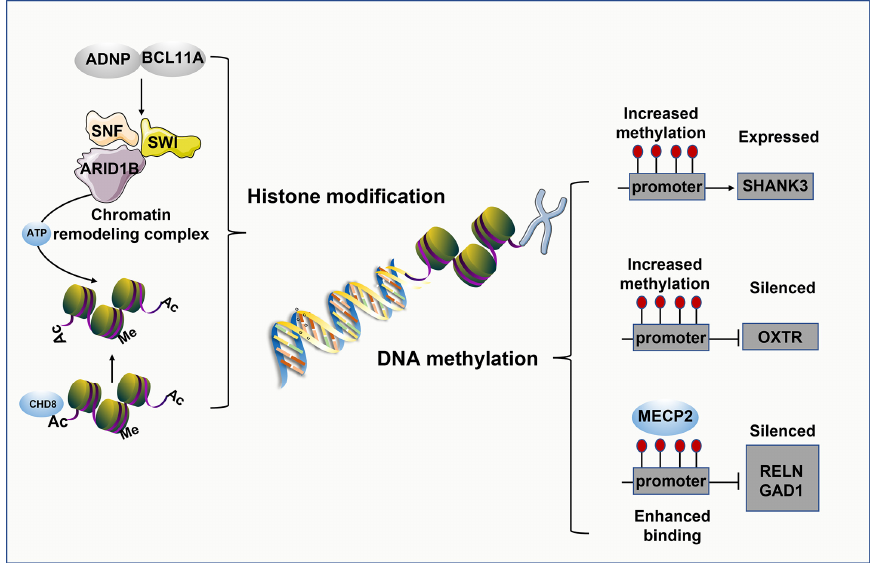
Figure 3. Methylation and acetylation modifications associated with ASD. DNA methylation fre- quently results in transcriptional repression or even gene silence in impacted genes. MECP2 binds to methylated CpG sites in gene promoters and binds to chromatin silencing complexes, inhibiting gene expression; protein modifications and chromatin remodeling in the acetylation group contribute to transcriptional activation or inactivation and chromatin packaging.